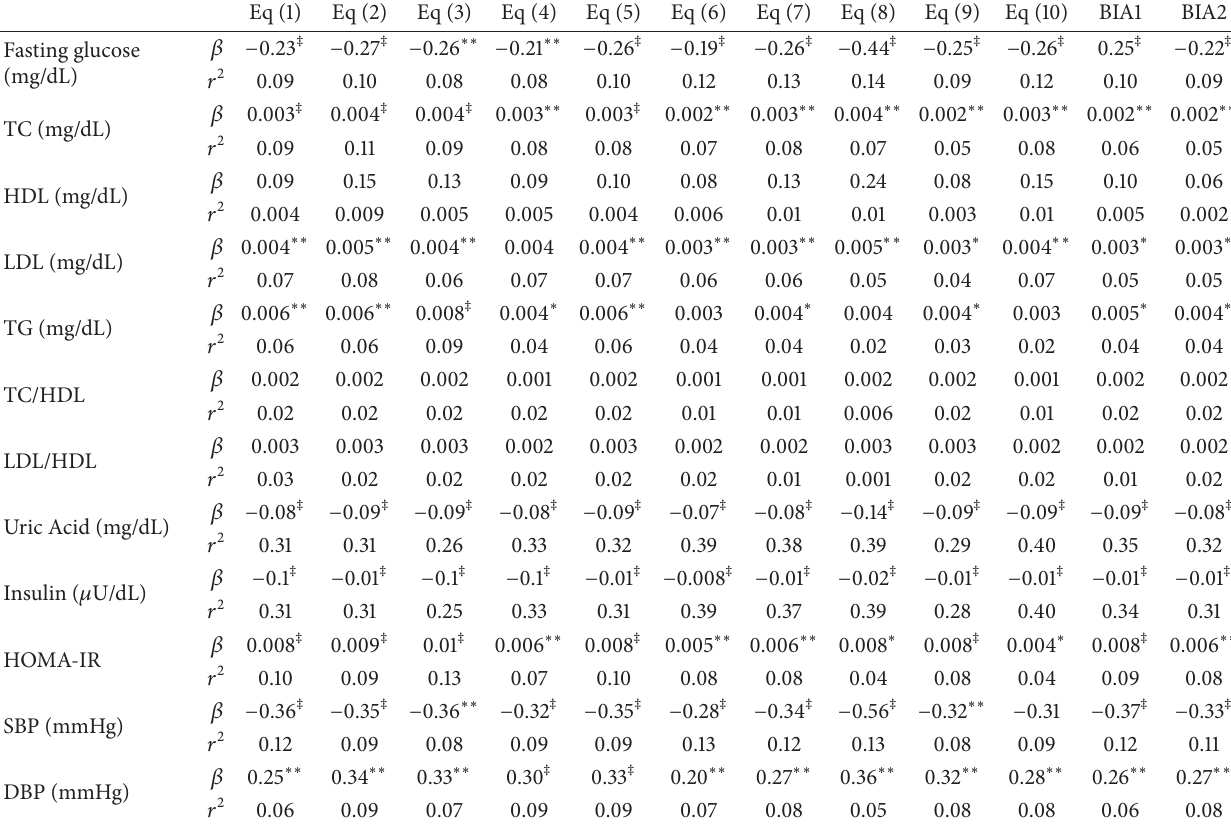
Table 3: Simple linear regression coefficient ( 𝛽 ) and coefficient of determination ( 𝑟 2 ) of the relationship between percentage of body fat and biochemical and clinical parameters in eutrophic adolescents (G1) (Vic¸osa, Minas Gerais, Brazil (2010)).